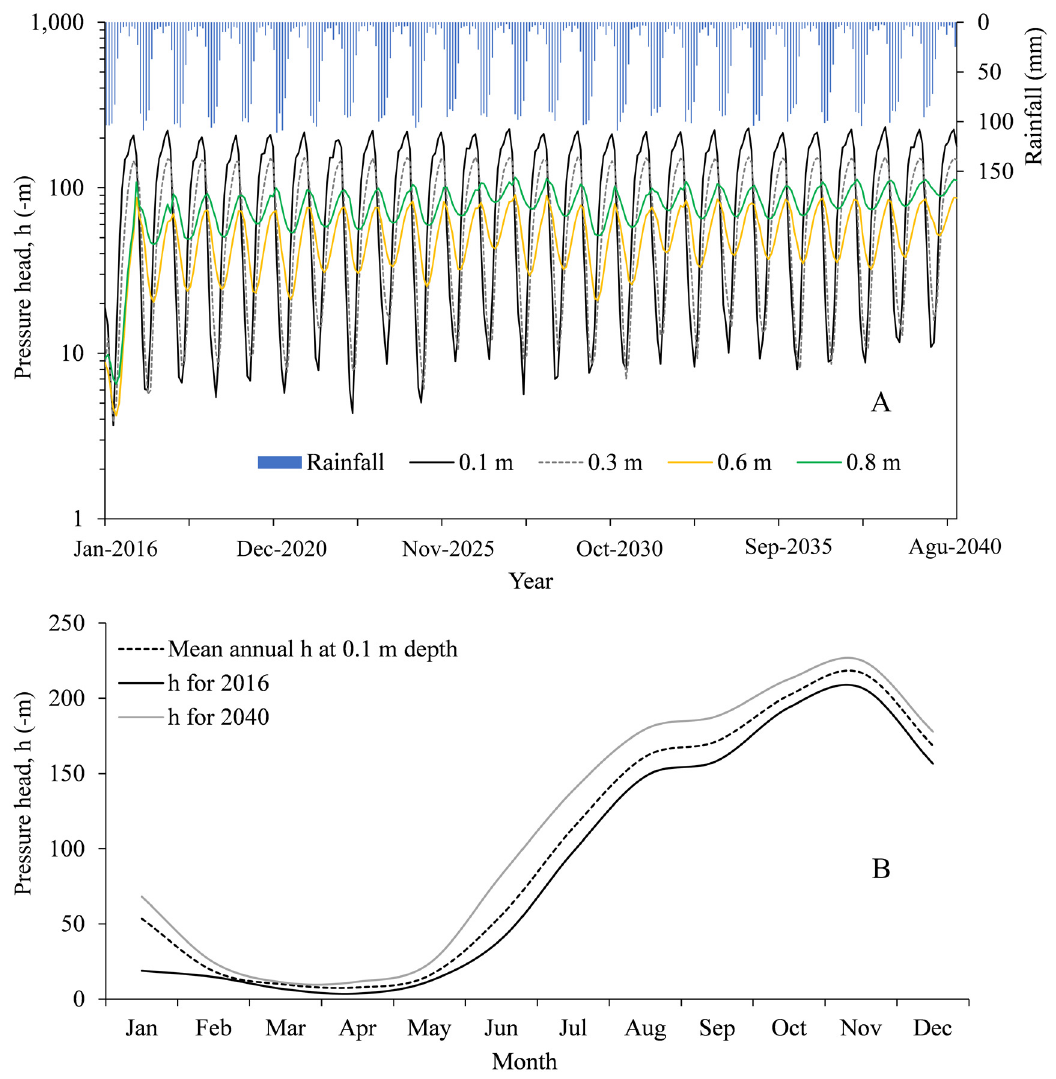
Figure 6. Average monthly soil water pressure head (h) of 100 realizations at four depths (0.1; 0.3; 0.6 and 0.8 m) together with monthly rainfall ( A ). Soil water pressure head at 0.1 m depth along the year, average for the simulated period and first (2016) and last (2040) simulated year ( B ).